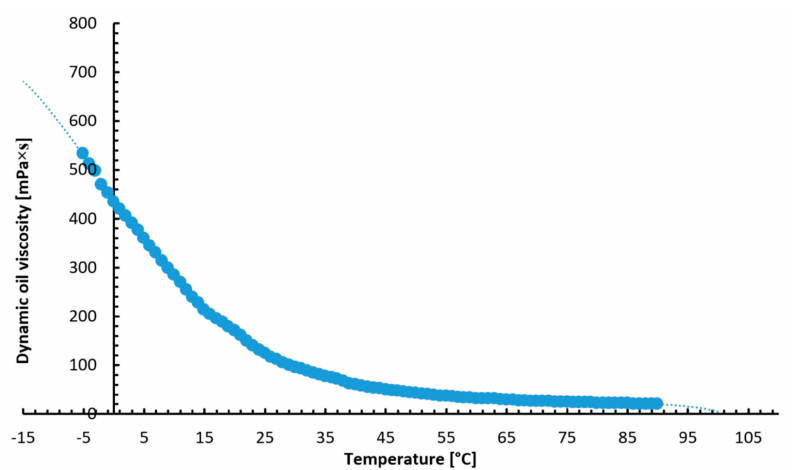
Figure 1. Dynamic viscosity of the 5W-30 oil in the temperature range from − 5 to 100 ◦